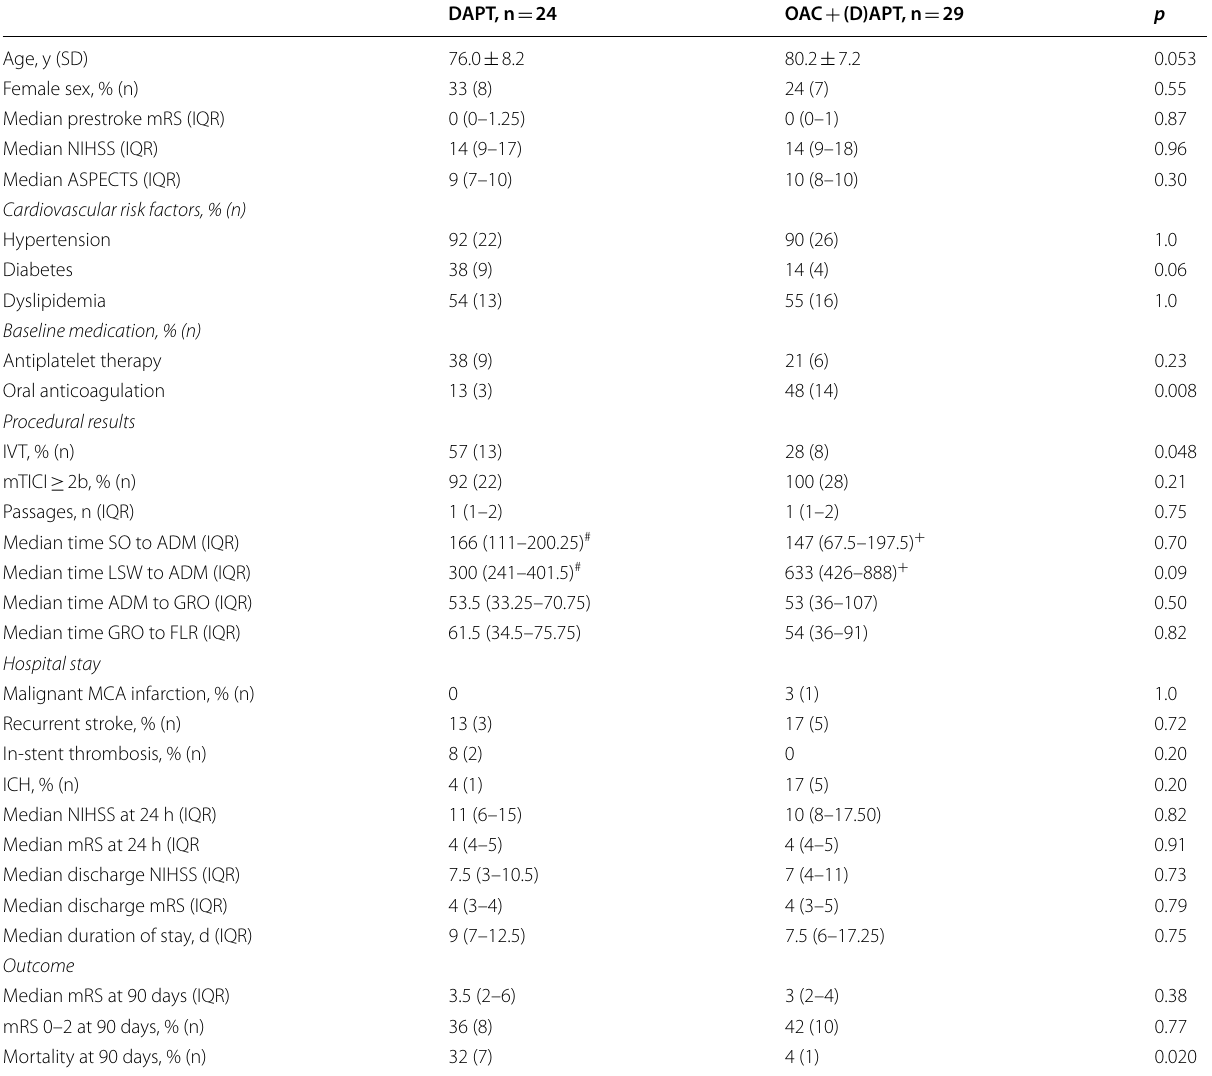
Table 2 Comparison of characteristics and outcome for patients discharged with dual antiplatelet therapy vs. oral anticoagulation in addition to single or dual antiplatelet